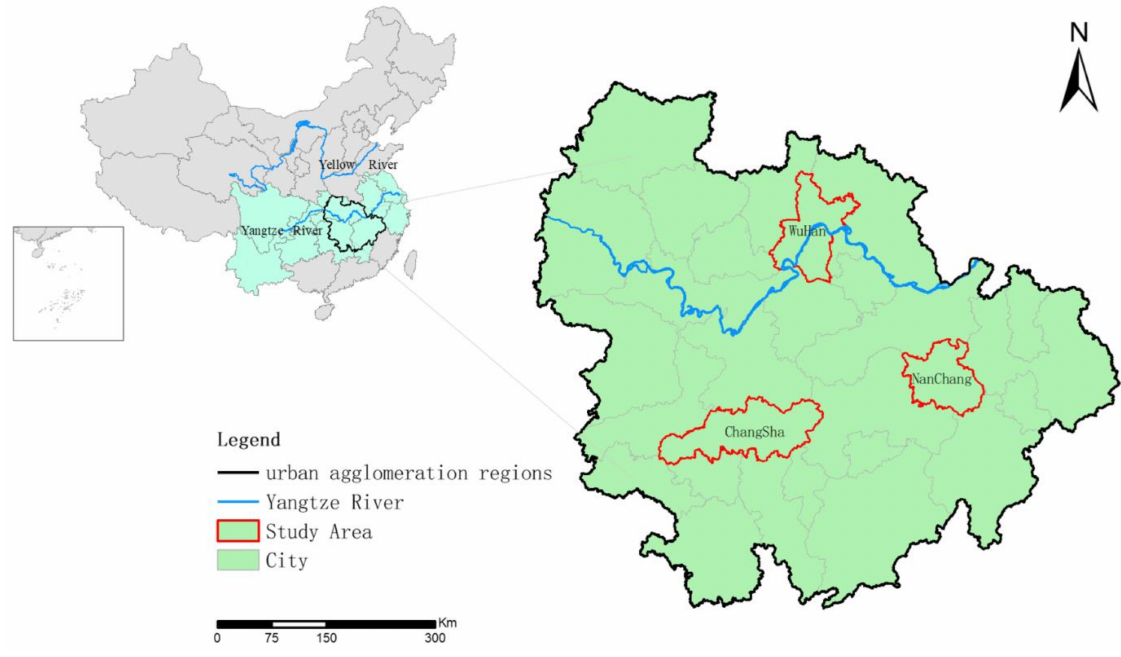
Figure 1. Study area and internal